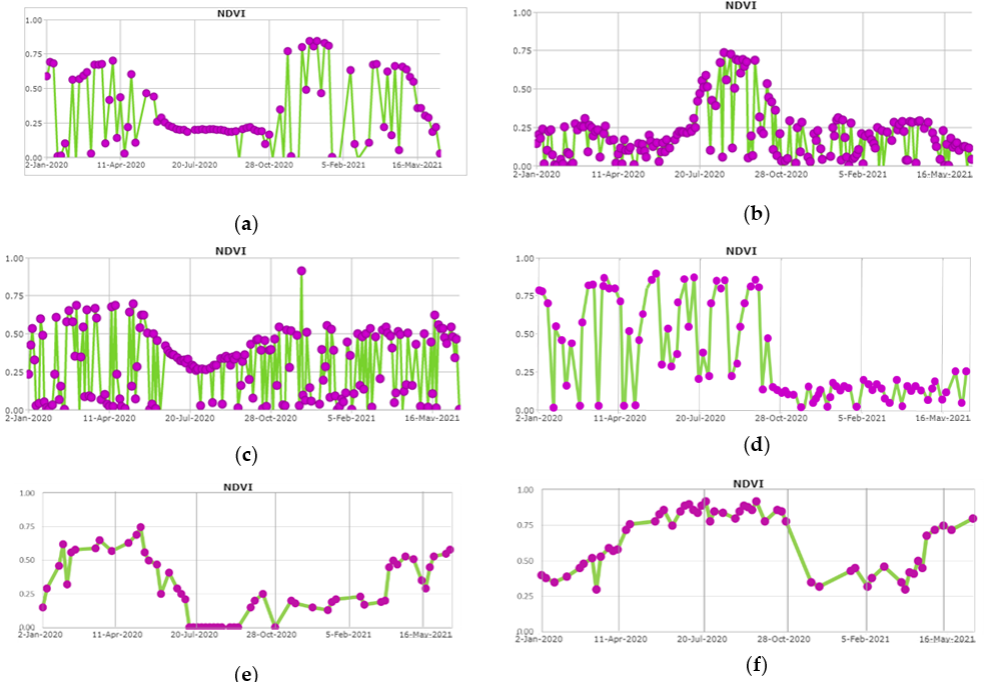
Figure 11. Vegetative activity through time in the vicinity of the photovoltaic plants analyzed by means of multitemporal NDVI graphs: ( a ) of the vegetation between the solar panels, ( b ) of the vegetation present in the adjacent right plot, ( c ) of the area without the presence of solar panels within the installation plot, ( d ) of the vegetation of the lower triangular plot, € of the vegetation surrounding the solar installation, ( f ) of the vegetation of the plot located to the left of the installa- tion.